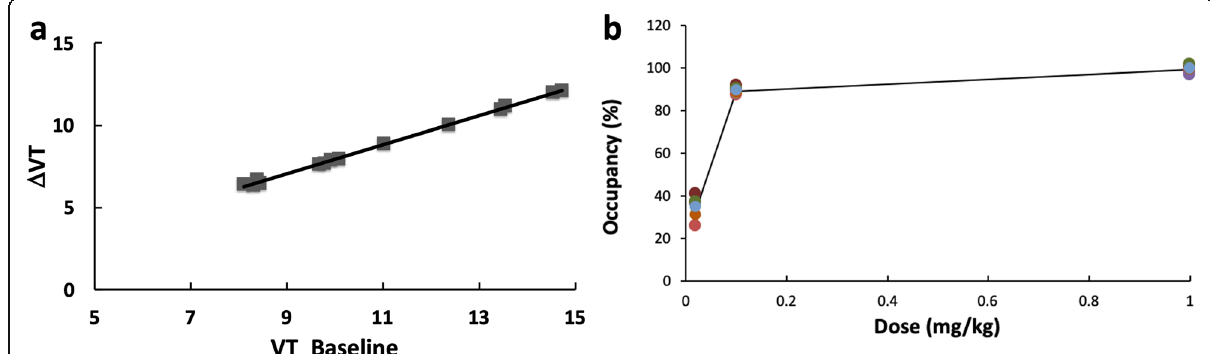
Fig. 6 Scatter plots of Δ V T vs baseline V T from a blocking study with 0.1 mg/kg dose ( a ), and the computed occupancy as a function of the blocking dose for all brain regions ( b )